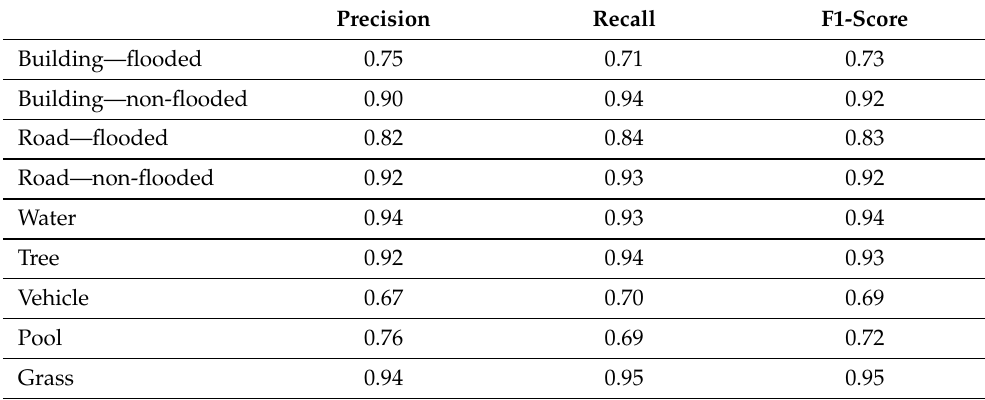
Table 2. Pixel-wise performance of proposed method using precision, recall and